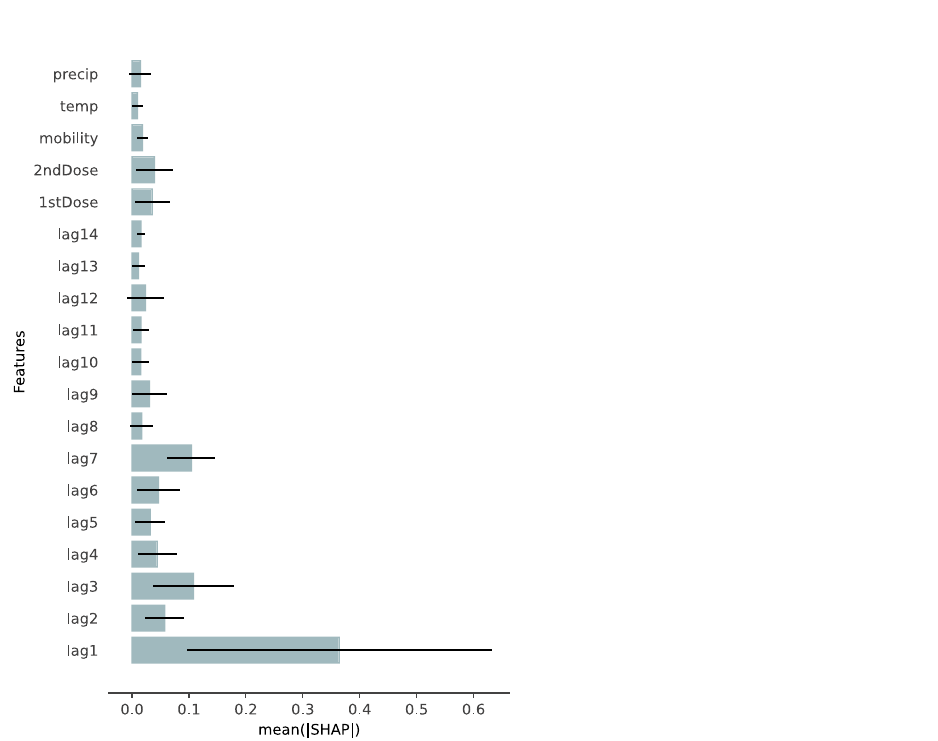
Figure 12. Mean absolute SHAP values (normalized). Error bars show the standard deviation across all the ML